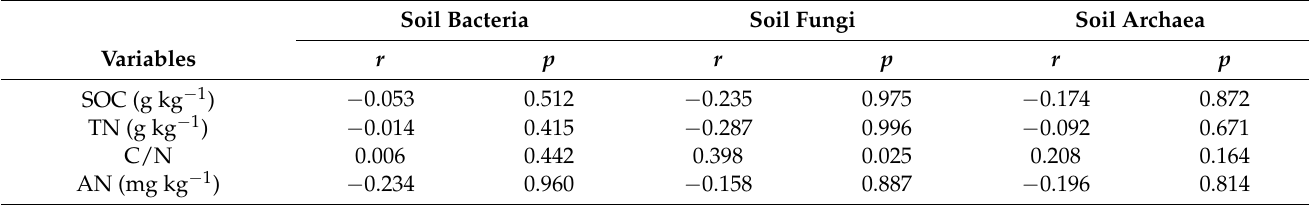
Table 9. The relationships between the environmental variables and the soil microbial community function based on mantel